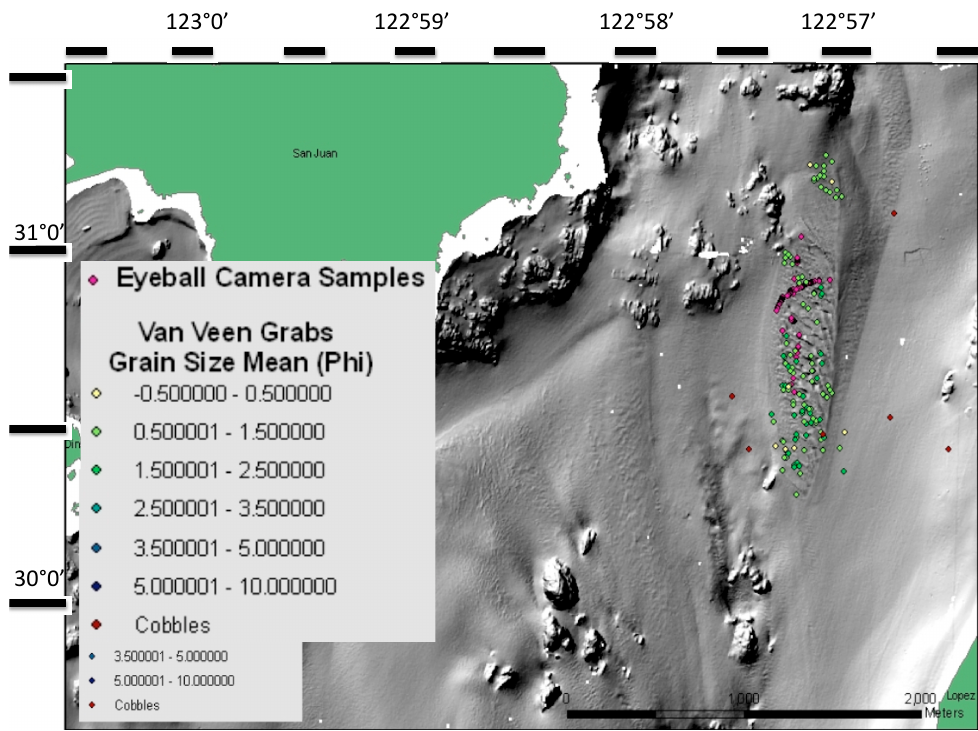
Figure 3. Locations of eyeball photo shots (purple dots) taken along transects of the San Juan Channel sand wave field using the USGS eyeball camera and sediment sample stations showing mean grain sizes (phi scale) in various colors. The objective of this figure is to show the density of sampling points within the sand wave field compared to samples taken outside of the field.